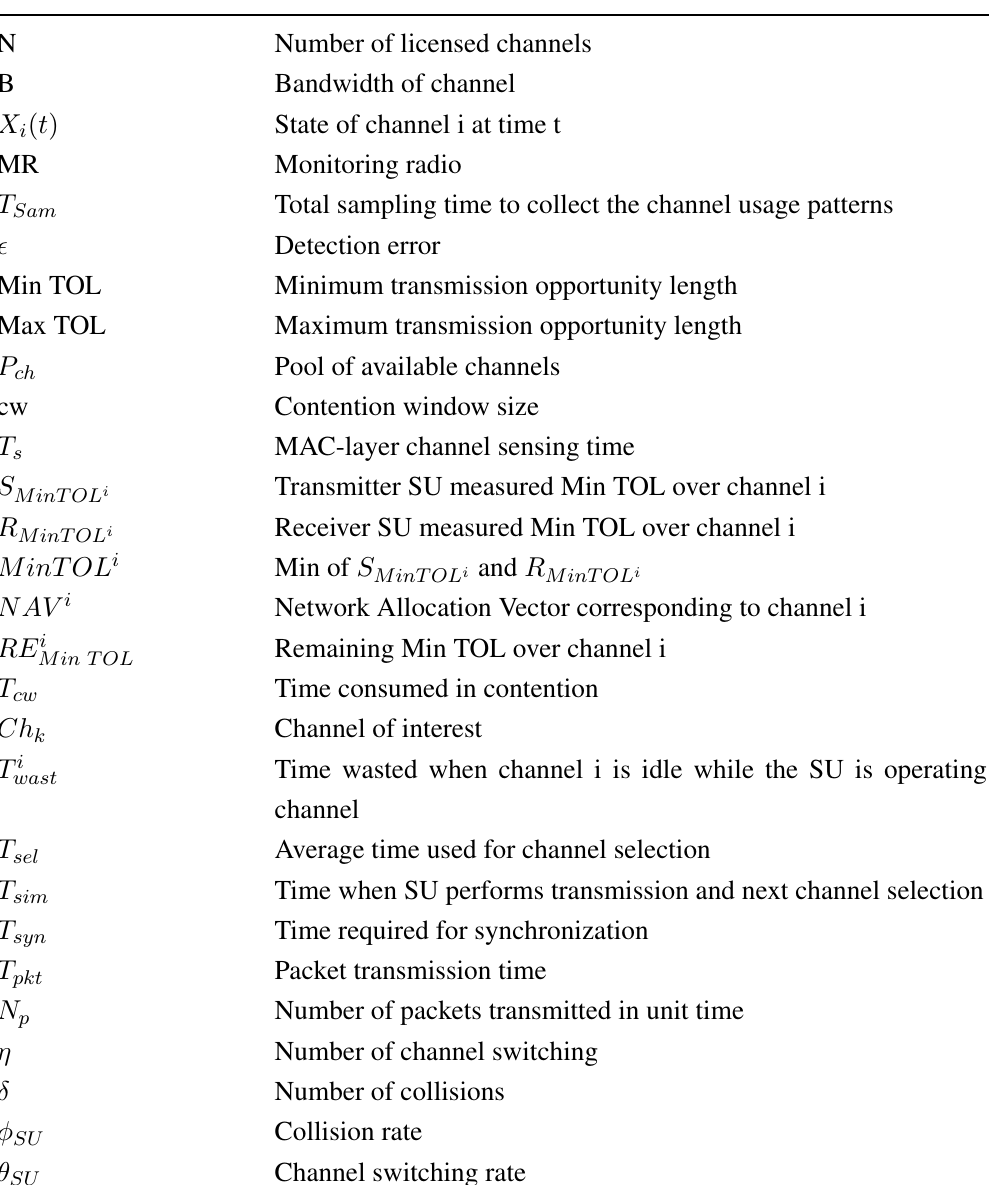
Table 1. List of symbols.